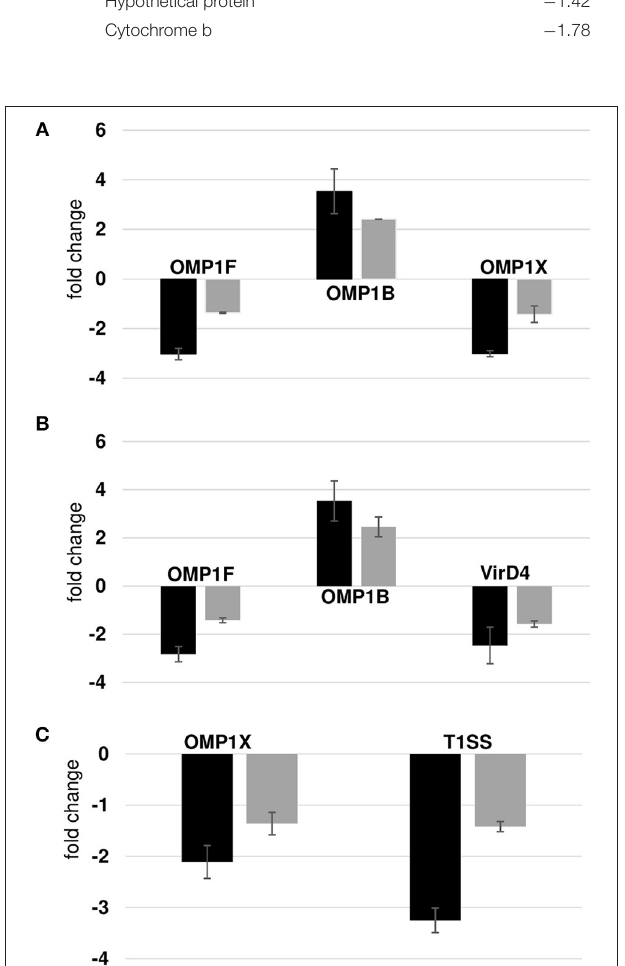
FIGURE 8 | Correlation between protein expression and RNA expression. Fold changes in wildtype vs. ECH_0379 mutant (A) or ECH_0490 mutant (B) or ECH_0660 mutant (C) were assessed by RT-PCR. Black bars represent qPCR data and gray green bars represents proteomics